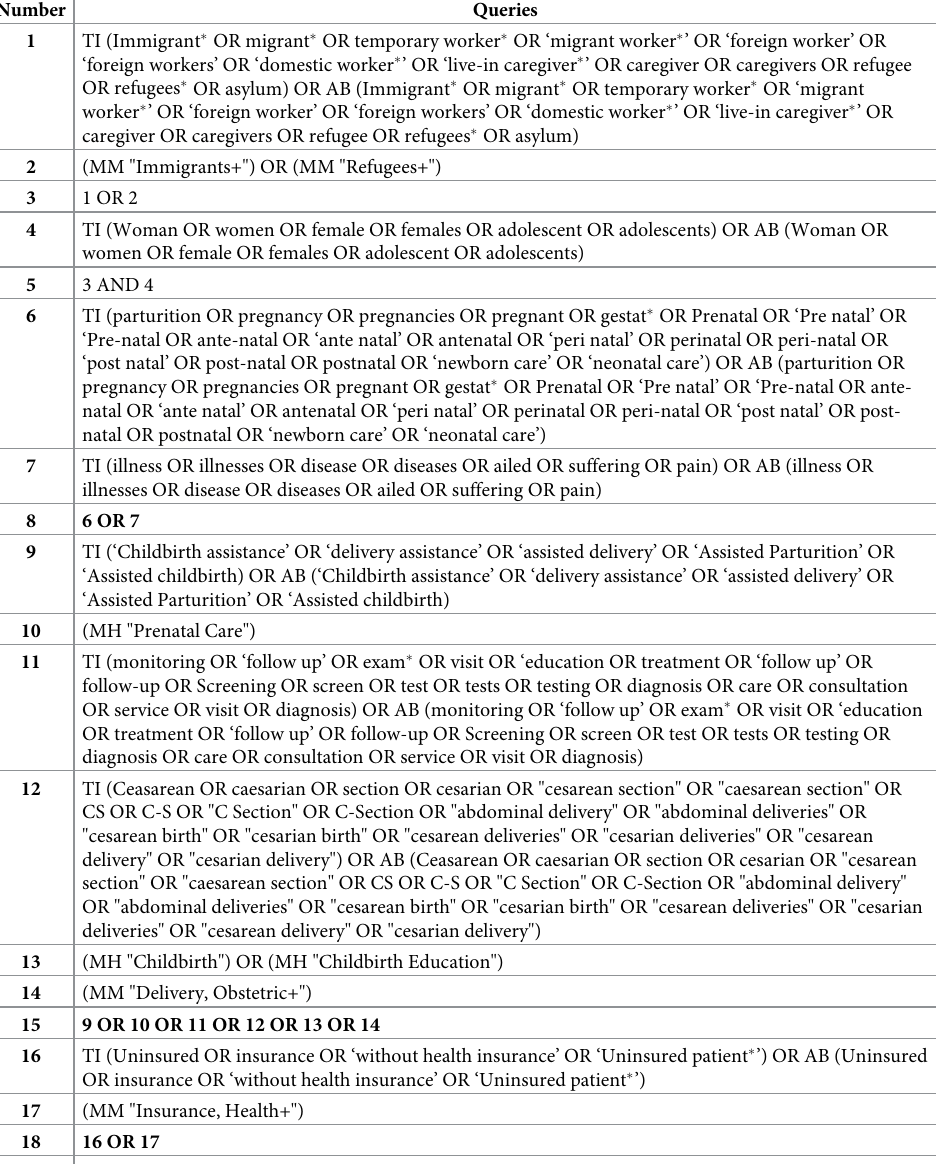
Table 3. Search strategy in CINAHL, to be modified as needed for other